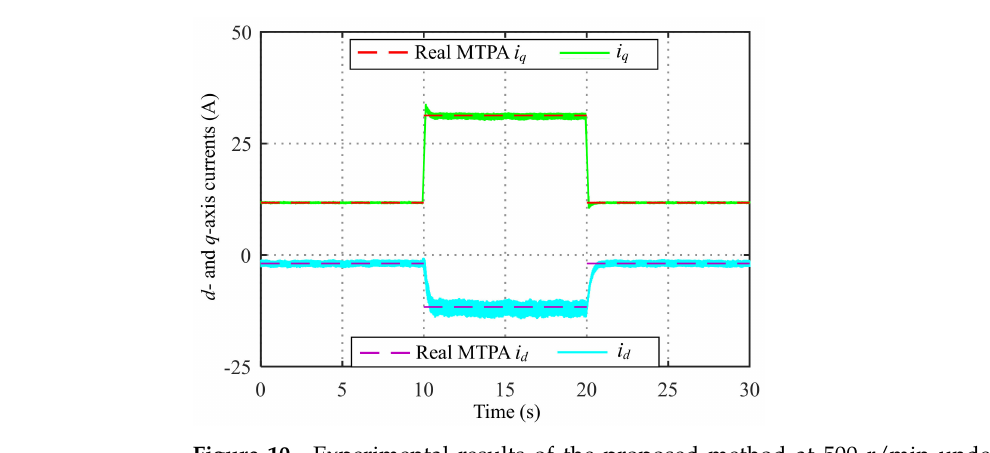
Figure 10. Experimental results of the proposed method at 500 r/min under a step torque of 10-30-10 N · m.